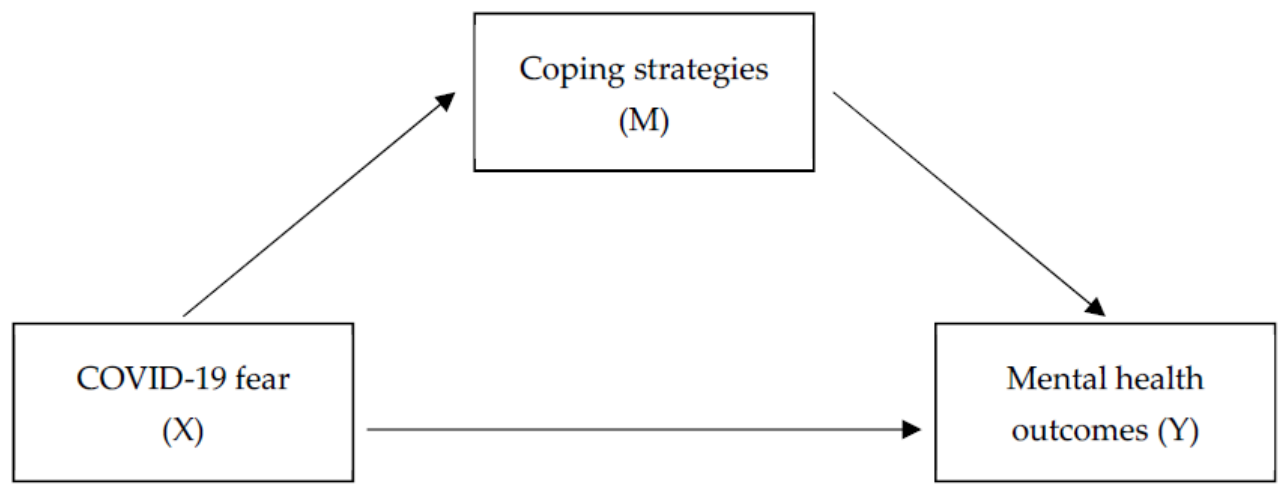
Figure 1. Coping strategies mediate the effects of COVID-19 fear on positive and negative mental health outcomes.